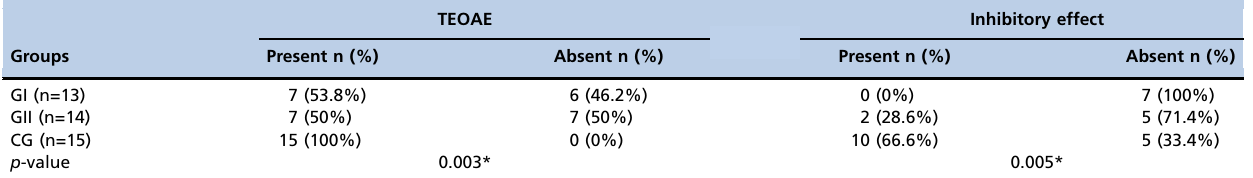
Table 3 - Distribution of the TEOAE results (presence or absence) and efferent auditory pathway ’ s inhibitory effect results, by individual (number and percentage).